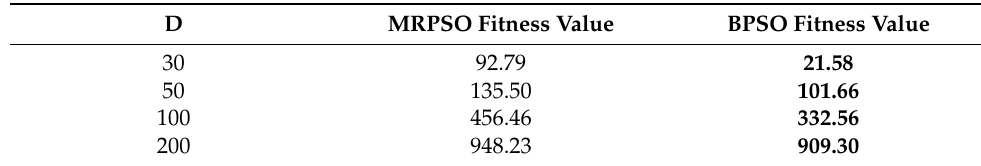
Table 16. Mean of the particle best-fit values in MRPSO and BPSO on f 3 . The bold numbers refers to the better results.